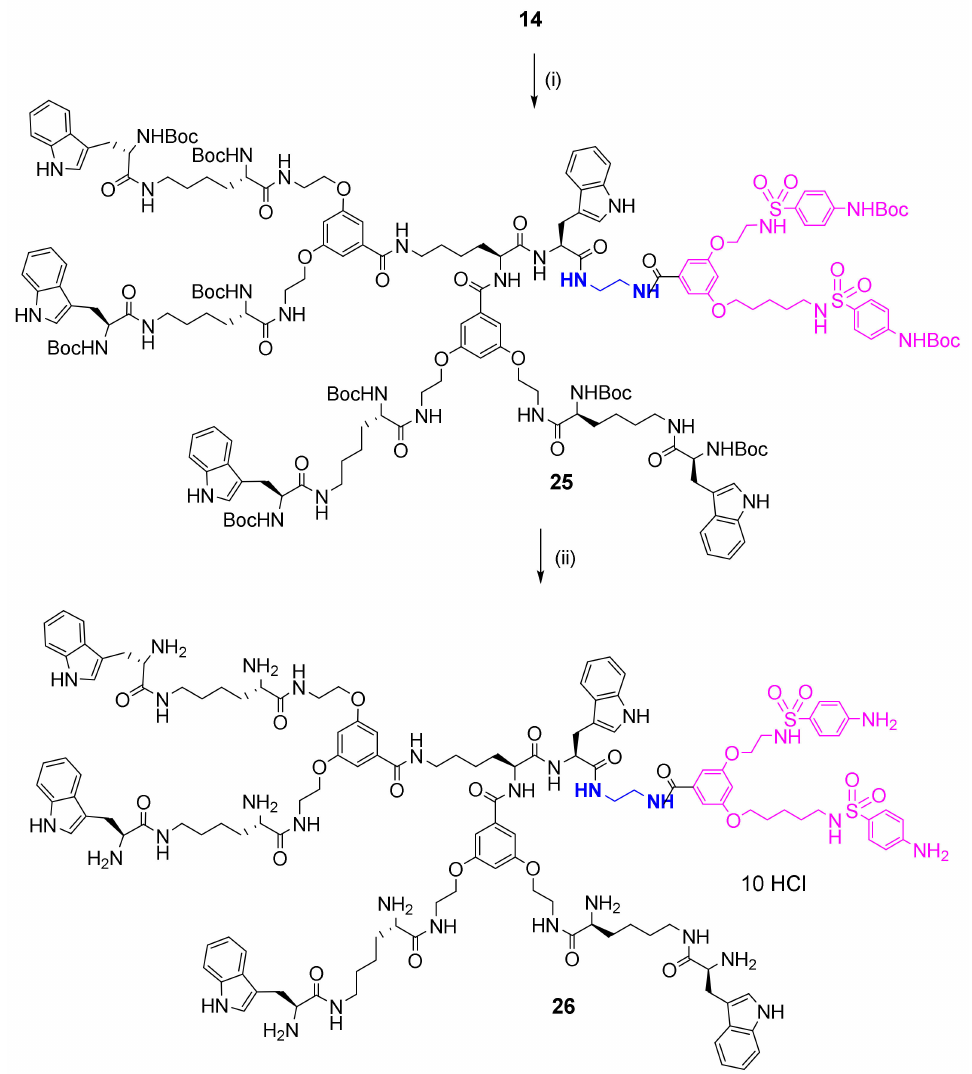
Scheme 6. Synthesis of Boc-protected compound 25 and unprotected compound 26 . Conditions: ( i ) EDC/HOBt, Et 3 N, DMF, five days; ( ii ) sat.